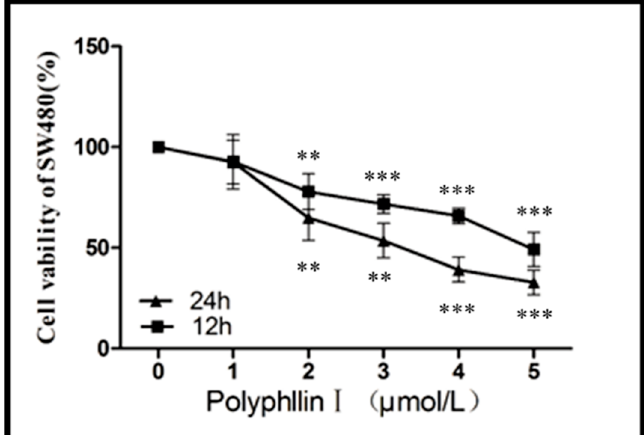
Figure 1. PPI inhibited the proliferation of SW480 cells. The cell viability of SW480 cells treated with different concentrations of PPI was assessed by MTT assay after 12 and 24 h. n = 6, the data are presented as means ± SEM. ** p ‐ value < 0.01; *** p ‐ value <